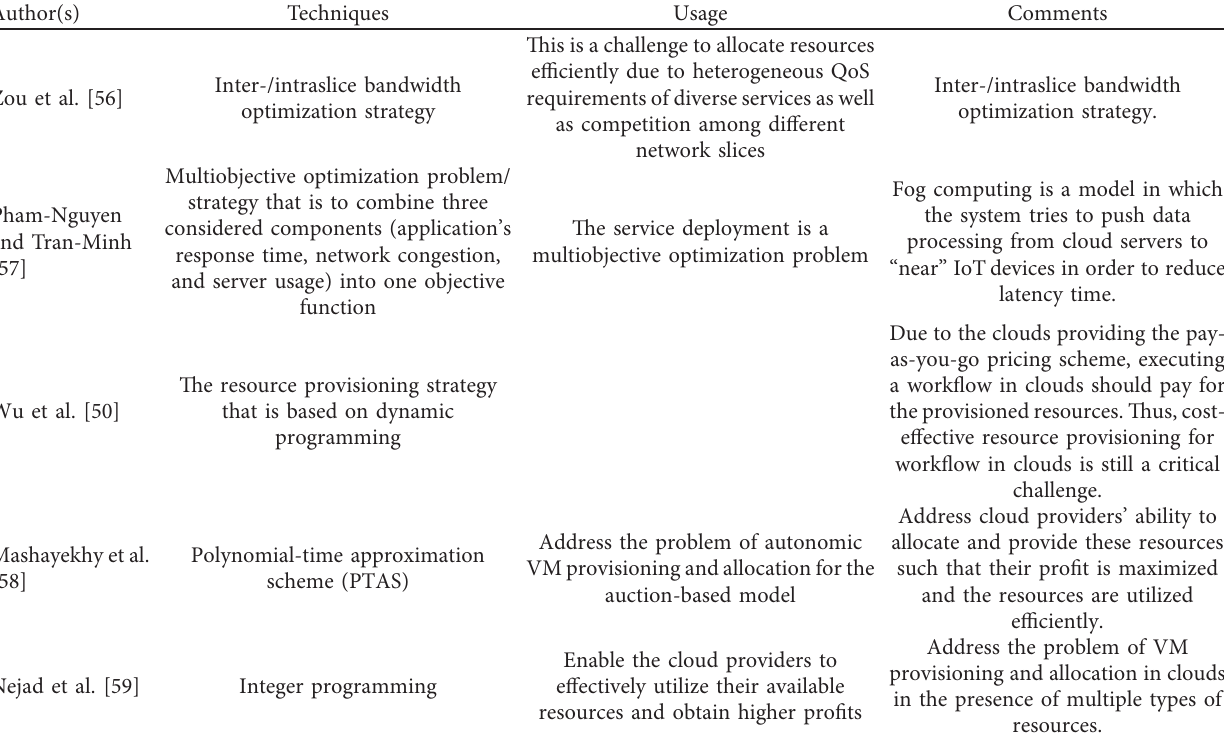
Table 5: A comparative analysis of game-theoretic models for resource provisioning in cloud